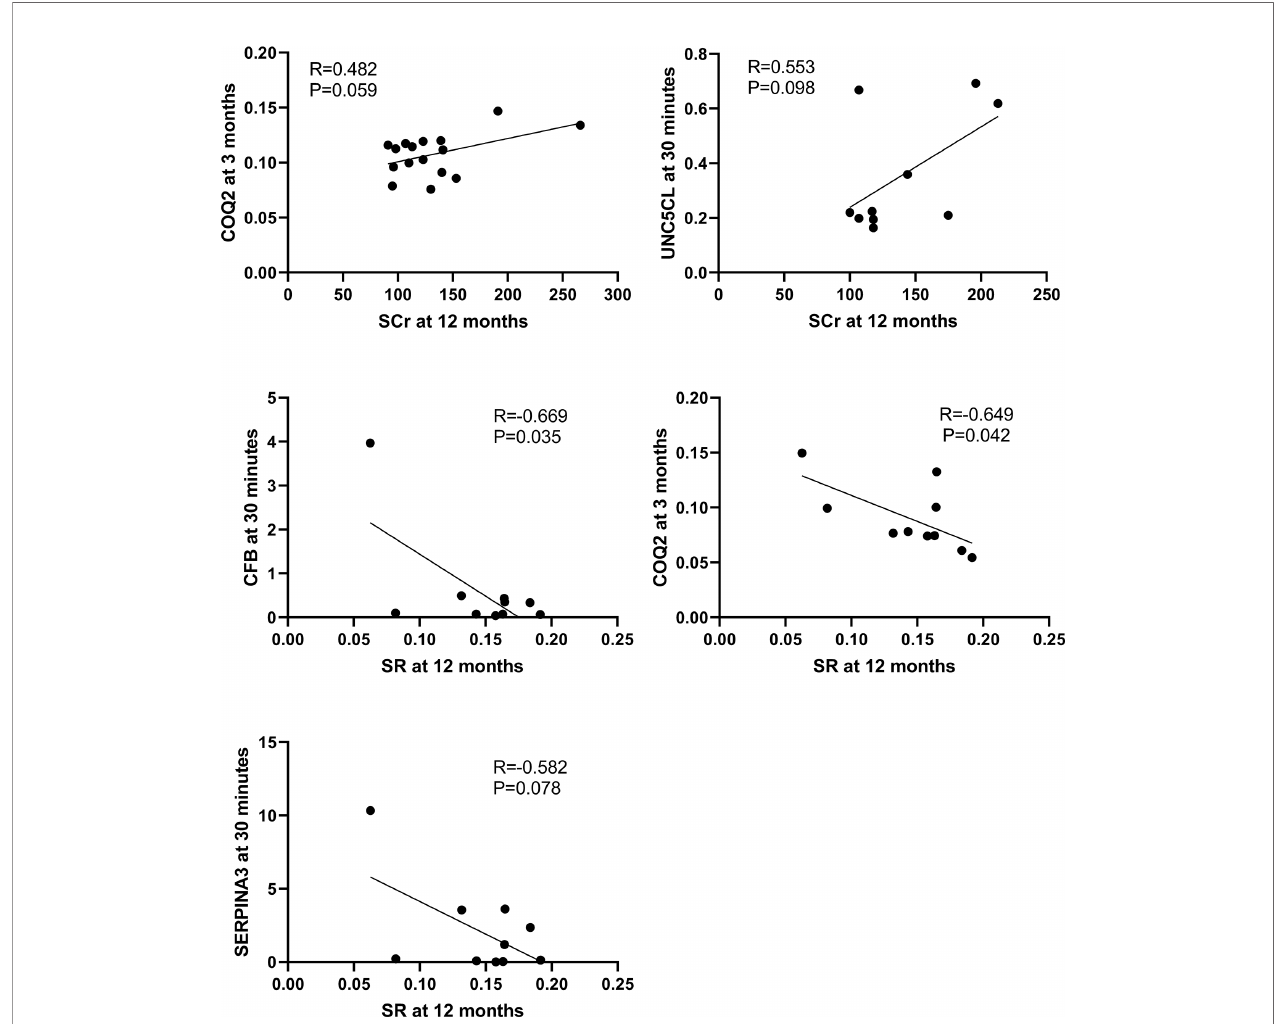
FIGURE 10 | Correlations between qPCR validated DEGs at 30 minutes or 3 months and SCr or SR at 12 months in the second cohort of 33 renal biopsies. The signi fi cant positive or marginal negative correlations were shown between COQ at 3 months or UNC5CL at 3 minutes and SCr at 12 months, as well as COQ, CFB or SERPINA3 at 30 minutes and SR at 12 months,